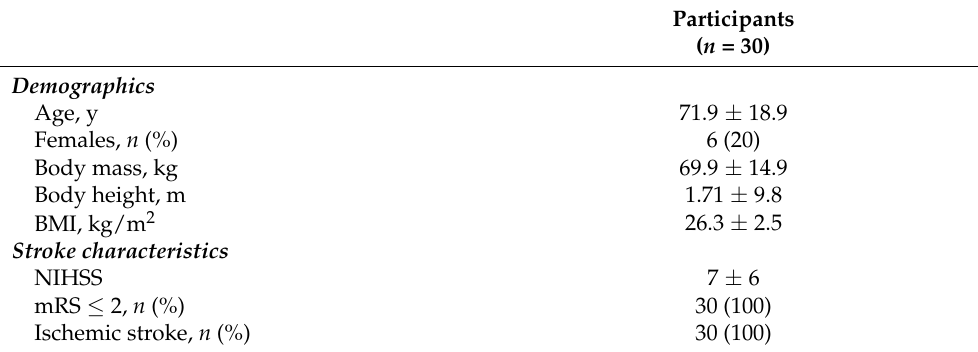
Table 1. Demographics and stroke characteristics of the included sample. Mean ± sd and proportions, as appropriate.